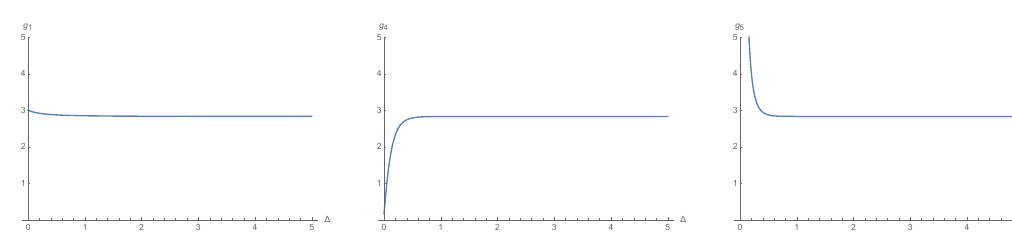
Figure 8 . The plots of the functions g 1 , g 4 , and g 5